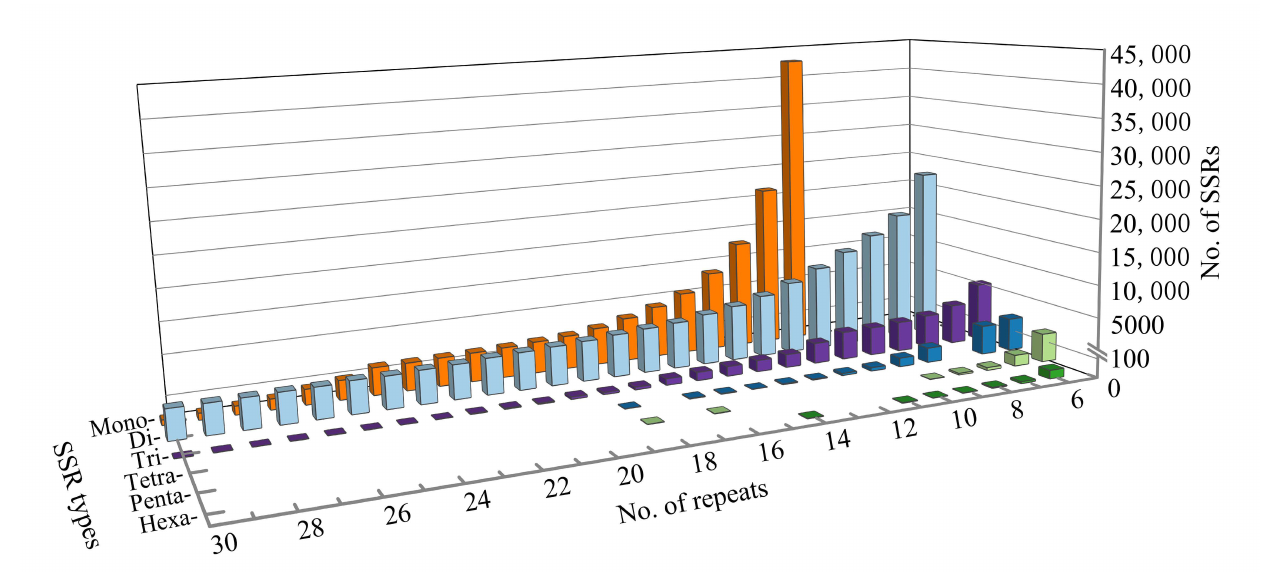
Figure 3. The number of repeat types with respect to the number of repeat motifs of SSRs in the N. colorata